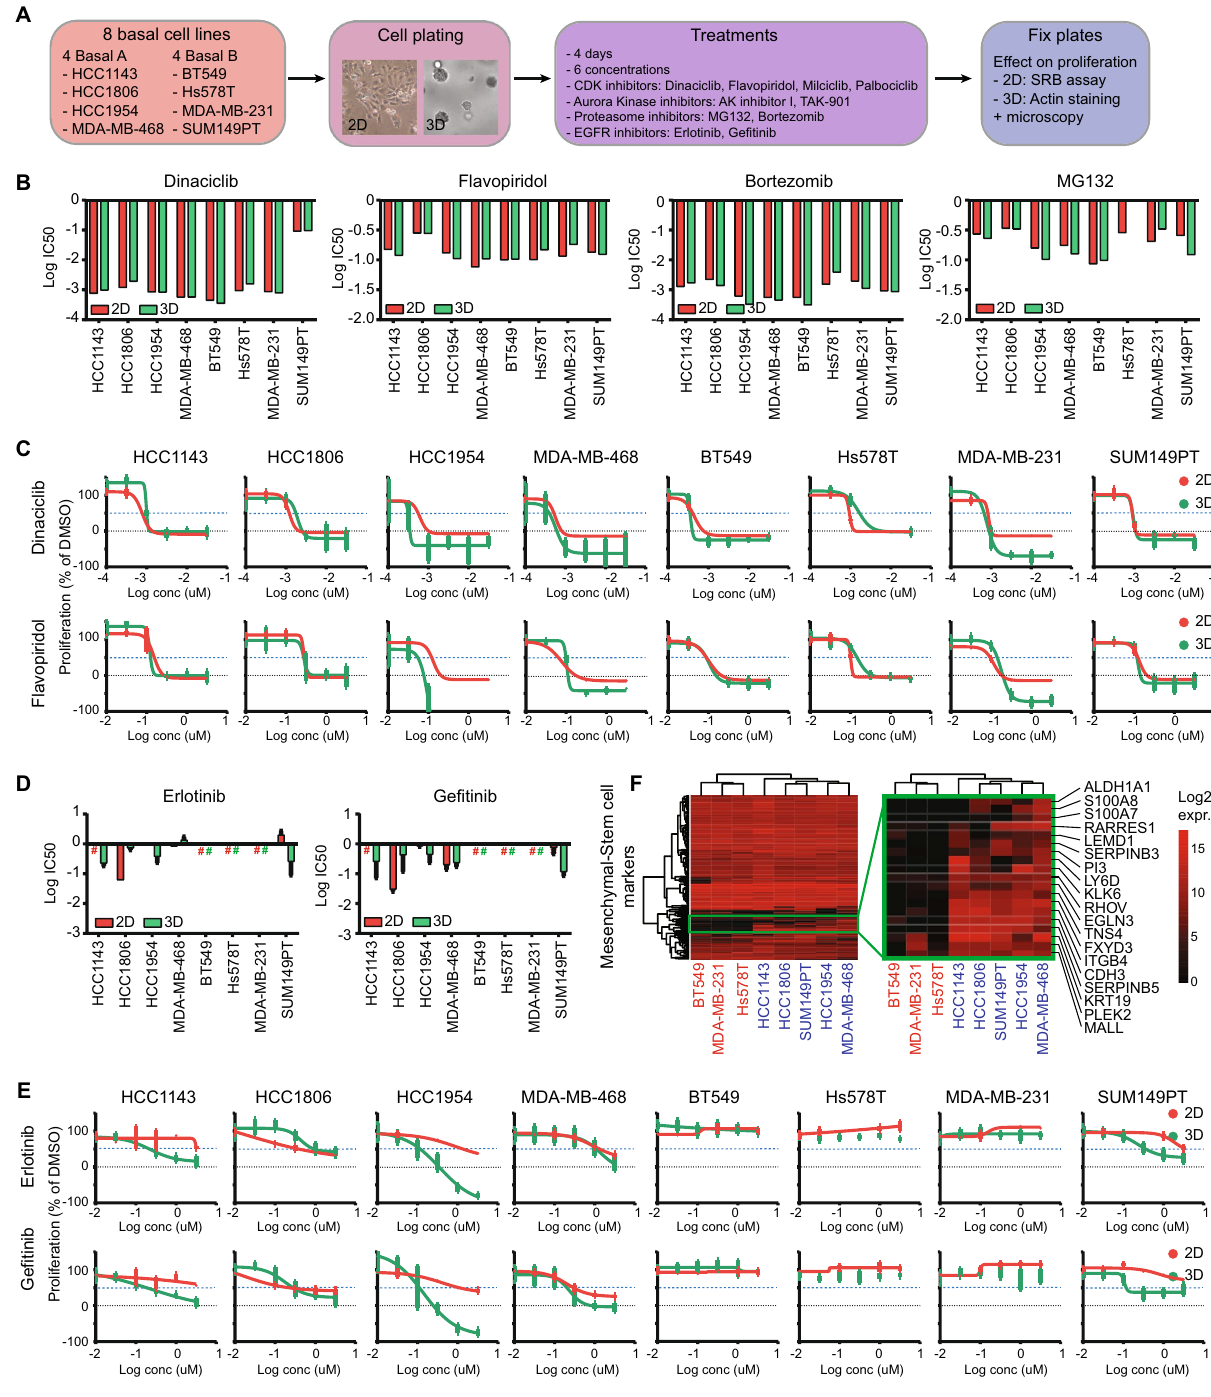
Figure 4. Effect of DEG inhibitors on cell line proliferation in 2D and 3D. ( A ) Experimental setup. 4 basal A and 4 basal B cell lines were plated in 2D and 3D conditions, after which they were treated with 6 different concentrations of CDK, Aurora Kinase, Proteasome or EGFR inhibitors. 4 days after treatment, cells were fixed and proliferation was assessed. ( B ) Log IC50 (uM) for CDK inhibitors dinaciclib en flavopiridol and proteasome inhibitors bortezomib and MG132 in 2D and 3D cultures of basal A and basal B cell lines. ( C ) Dose response curves of dinaciclib en flavopiridol in 2D and 3D cultures of basal A and basal B cell lines. Mean + stdev for technical duplicates in 2D cultures. Mean + stdev for technical quadruplicates in 3D cultures. ( D ) Log IC50 of EGFR inhibitors erlotinib and gefitinib in basal A and basal B cell lines. ( E ) Dose–response curves of erlotinib and gefitinib in 2D and 3D cultures of basal A and basal B cell lines. Mean + stdev for technical duplicates in 2D cultures. Mean + stdev for technical quadruplicates in 3D cultures. ( F ) Heatmap (complete linkage, Euclidean distance) of log2 expression of mesenchymal-stem cell markers in basal A and basal B cell lines. Cell line color indicates 3D invasiveness; red = invasive, blue =